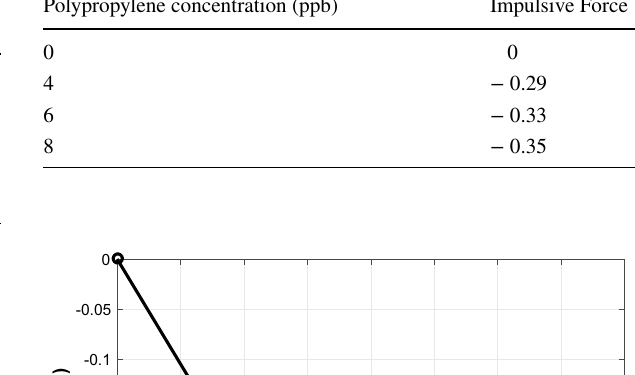
Table 4 Impulsive forces of polypropylene beads Polypropylene concentration (ppb)